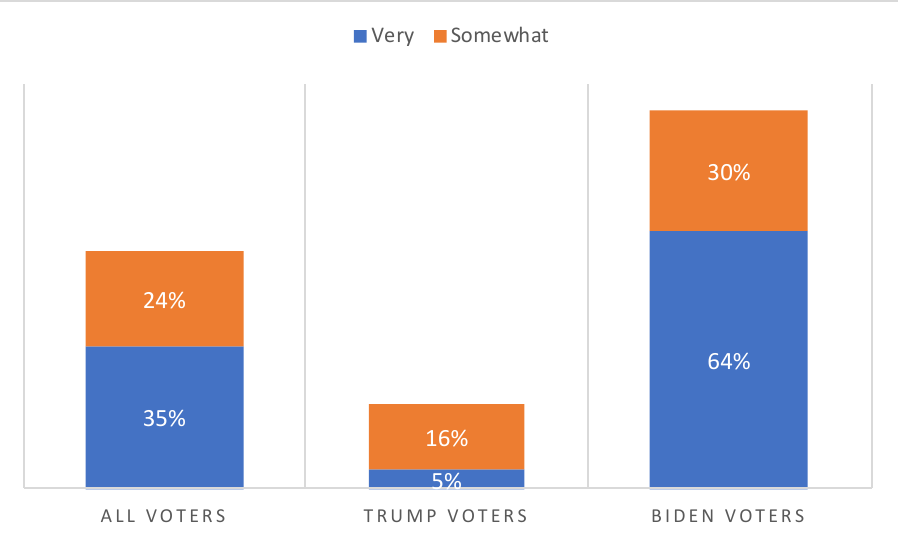
Figure 4. Percentage of voters who believe that the U.S. elections have been well managed. Source: Own elaboration from Pew Research’s American Trend Panel